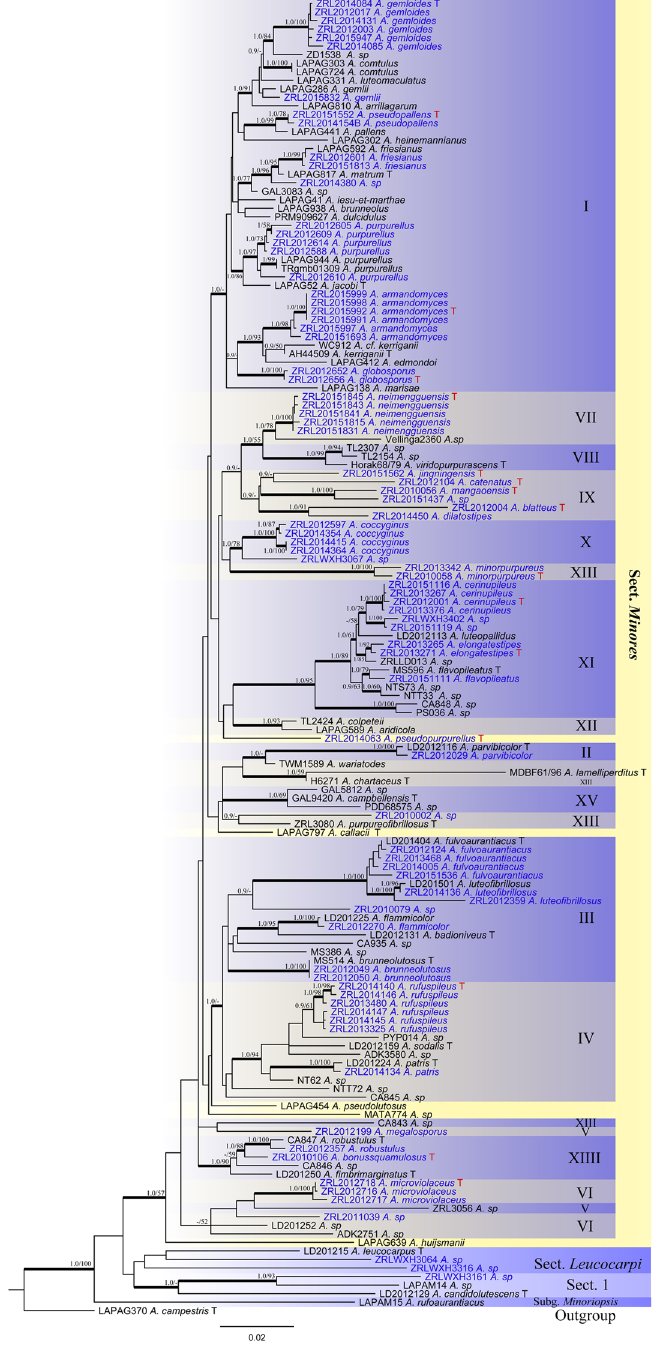
Figure 1. Maximum Likelihood (ML) tree of Agaricus section Minores based on LSU, tef1- α , rpb2 and ITS sequences with the outgroup Agaricus campestris . The Bayesian posterior probabilities and bootstrap support values more than 0.9/50% (PP/BS) are indicated at the nodes. The branches in Bold mean the related PP > 0.95. Sequences produced from this study are in blue. “T” refers to sequences from type specimen, and “T” in red refers to the sequences from type specimen and new to science from this